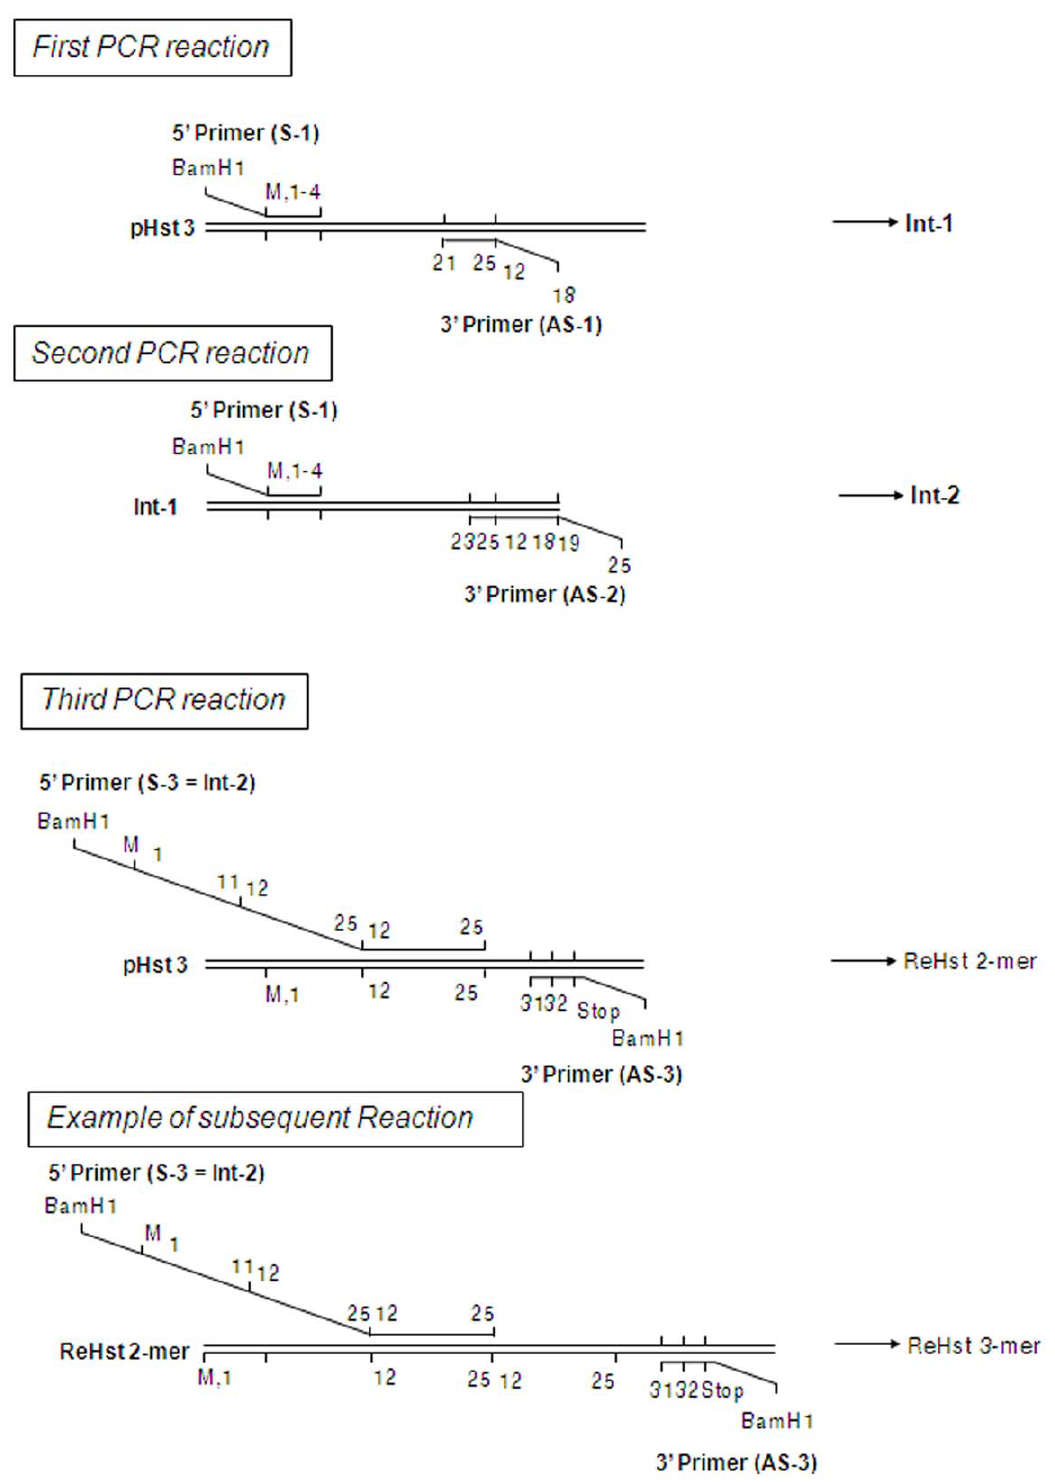
Figure 1. PCR reactions using splice overlap extension to generate recombinant histatin variants. In the first PCR reaction primer S-1, anti-sense primer AS-1, and template pHst3 were used to generate an intermediate product designated Int-1. In the second PCR reaction, Int-1 served as the template with S-1 and AS-2 as primers to generate a second intermediate product (Int-2). Int-2 was used as the sense primer (S-3) for the following reaction with AS-3 as the anti-sense primer and pHst3 as the template to generate the reHst3 2-mer construct. In subsequent cycles, Int-2 annealed with any of the functional domains of the products from preceding cycles to generate constructs with multiple functional domains.